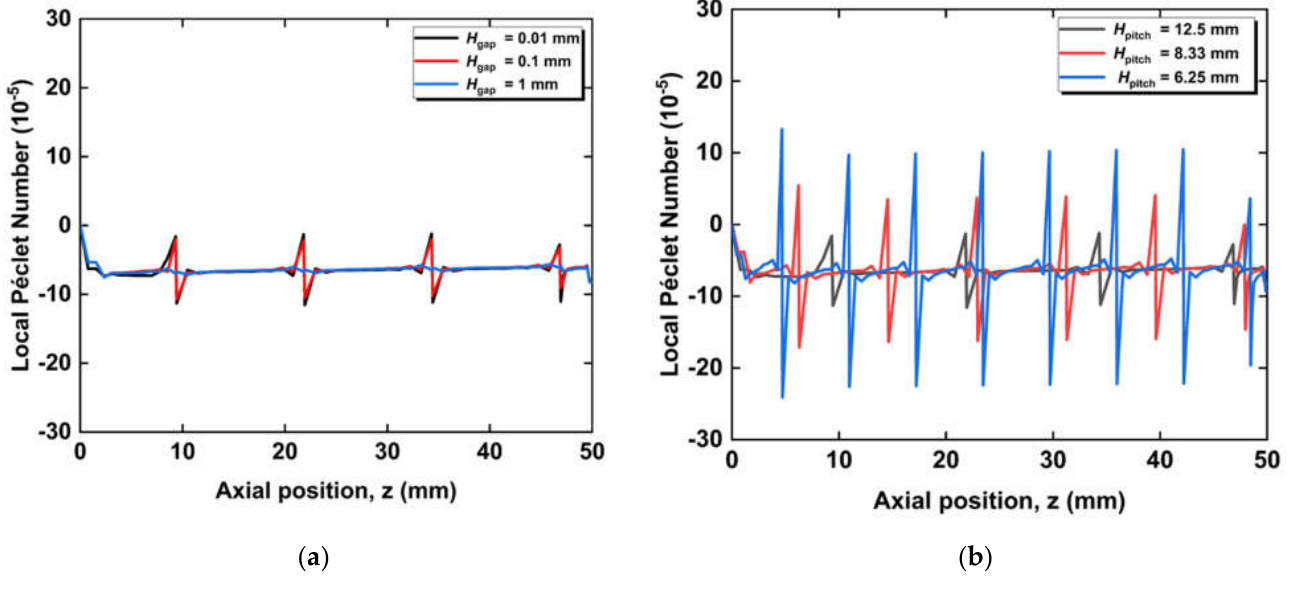
Figure 14. Local Péclet number variation in the anode-fuel channel interface along the axial direction with helical screw insert for 3 different ( a ) gap cases and ( b ) pitch cases.